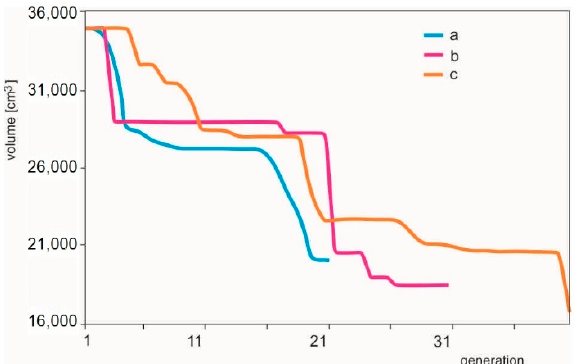
Figure 6. Changes of the volume of bars during the optimization of the 29 bar structure (a—12 individuals within 20 generations; b—8 individuals within 30 generations; c—15 individuals within 40 generations).